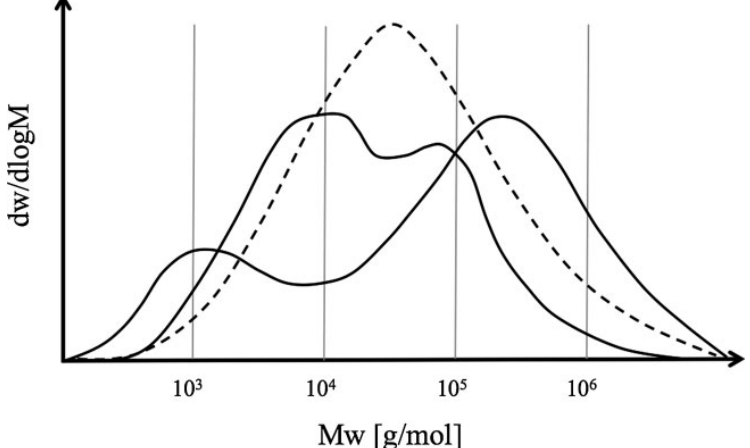
Figure 6. Illustration of a typical uni-modal (dashed) and two different bimodal molecular weight distributions (MWDs), reprinted with permission from [45]. Copyright 2012